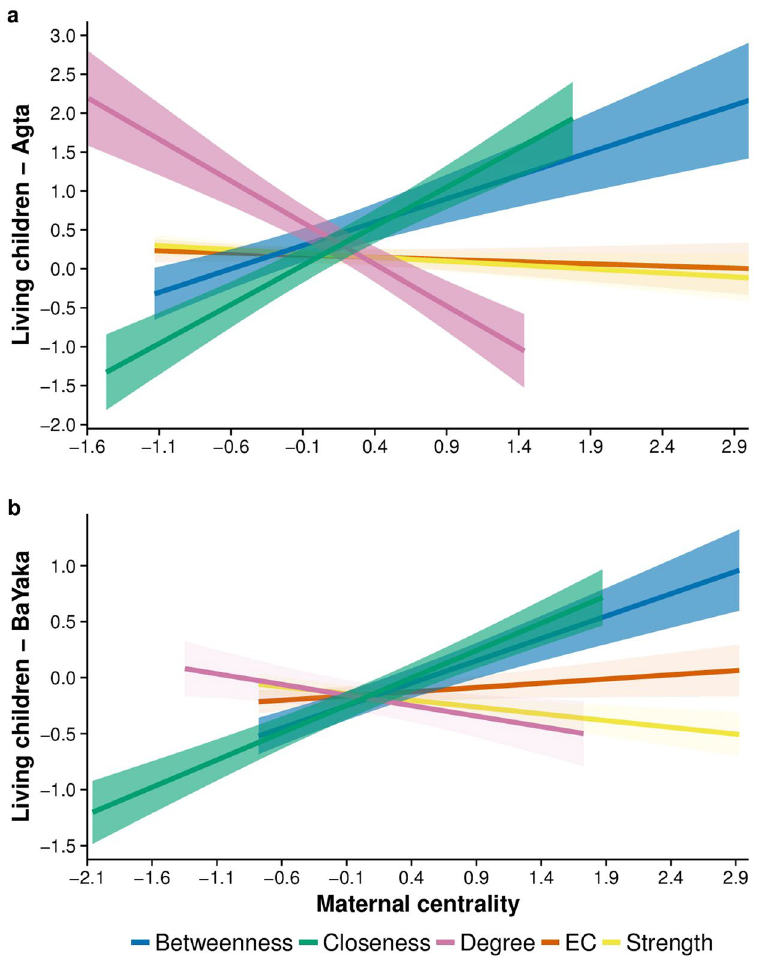
Figure 2. Age-controlled number of living offspring and five different measures of maternal centrality for ( a ) Agta ( n = 39) and ( b ) the BaYaka ( n = 38). Darker shaded areas represent significant results at p < 0.05. Shaded areas represent 95% confidence